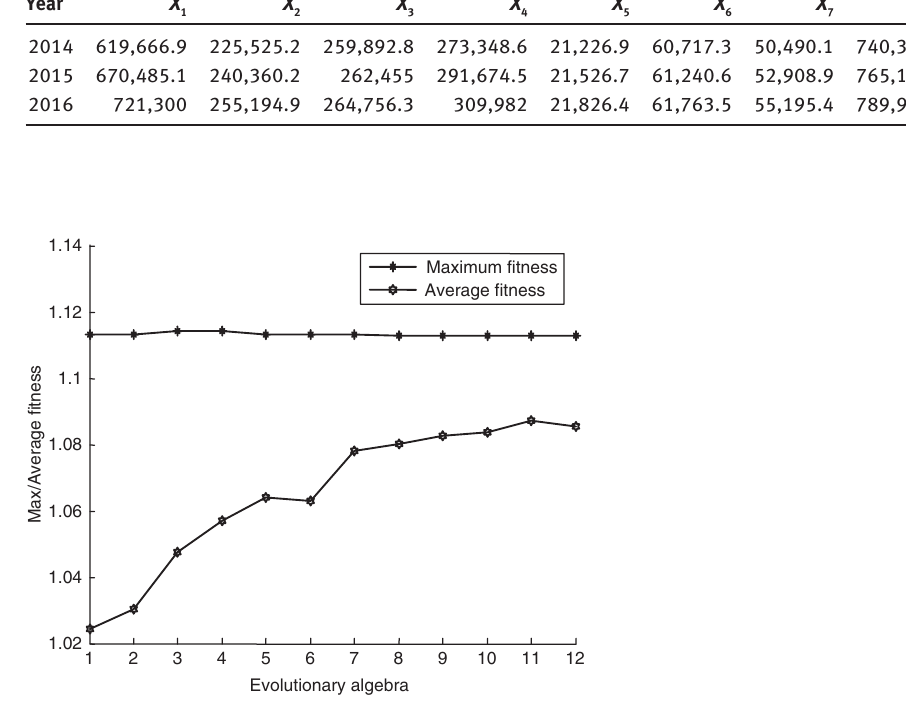
Figure 3: 2015 Smoothing Factor of Railway Freight: Incremental Fitness Curve